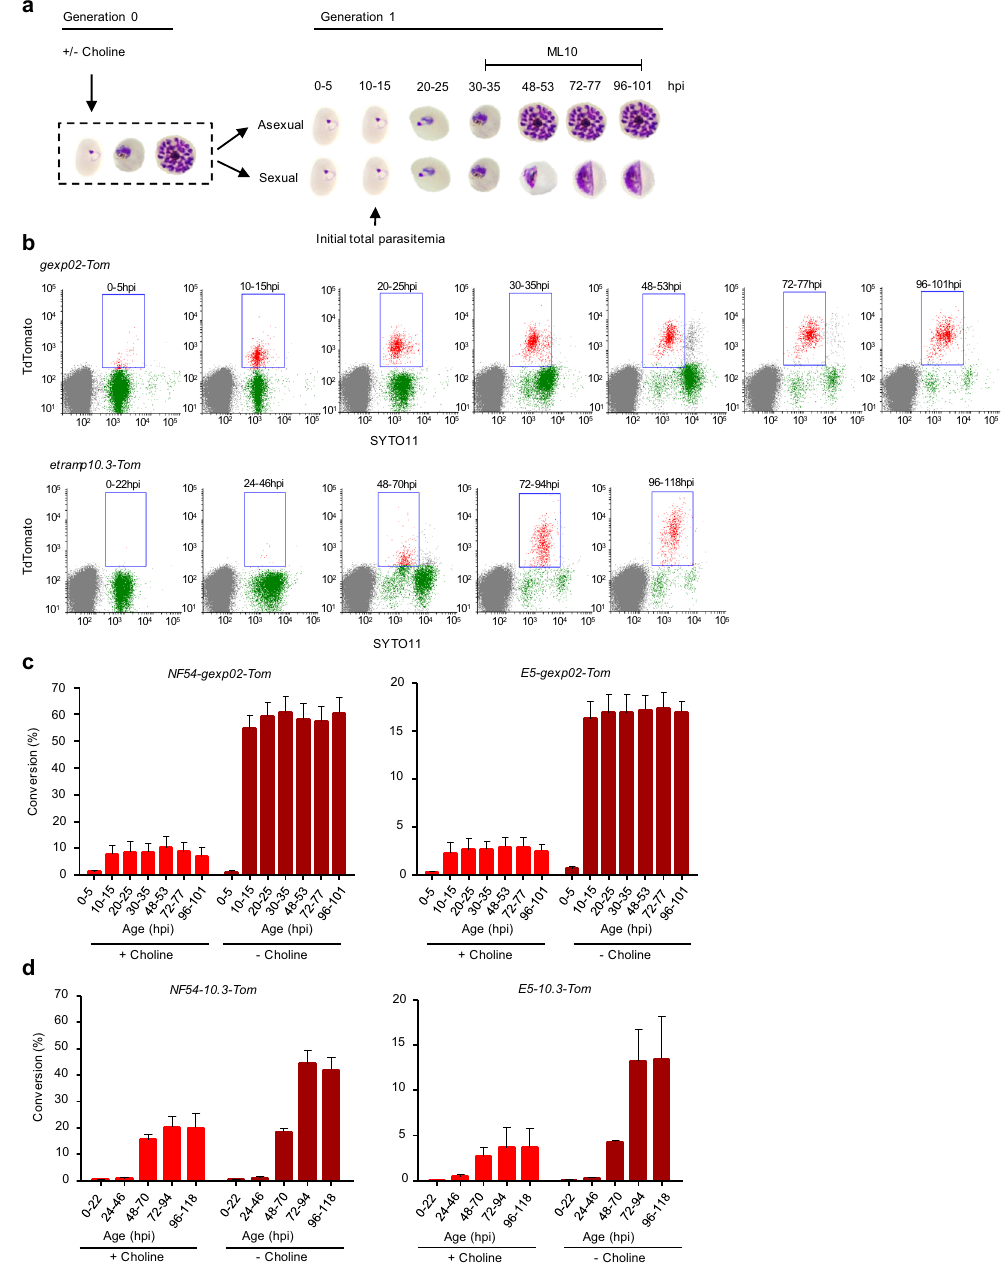
Figure 3. Flow cytometry-based time-course analysis of gexp02 -tdTom and etramp10 . 3 -tdTom expression during sexual development. ( a ) Schematic overview of the experiment design. Cultures were either maintained in the presence of choline, or with choline removed at the ring stage to induce sexual conversion. After reinvasion, the proportion of tdTom-positive parasites was determined by flow cytometry at several times (the times shown correspond to experiments with the gexp02-Tom lines, which were synchronized to a 5 h age window). ML10 was added at the trophozoite stage (generation 1, as indicated) to prevent schizont rupture and reinvasion. (b) Representative flow cytometry SYTO11 (stains DNA) – tdTomato plots for the NF54- gexp02-Tom and NF54-etramp10 . 3-Tom transgenic lines (- choline condition) at different times after invasion. Gates (rectangles) indicate SYTO11 and tdTomato double-positive parasites. (c) Quantification of sexual conversion rates at different times in the NF54-gexp02-Tom and E5-gexp02-Tom lines, based on detection of tdTomato fluorescence. Conversion rates (%) were determined as the gametocytemia relative to the initial rings parasitemia. Data are presented as the average and s.e.m. of three independent biological replicates. (d) Same as panel c, but for the NF54-etramp10 . 3-Tom and E5-etramp10 . 3 - Tom lines. Data are presented as the average and s.e.m. of two independent biological